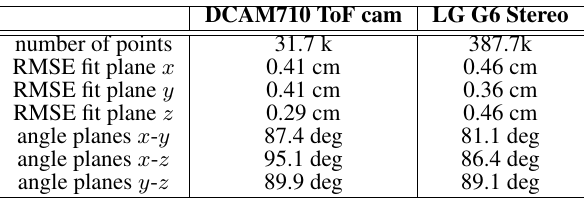
Figure 13. Box reconstructed with stereo vision from images acquired with LG G6 dual camera. Table 4. Comparison between TOF camera and smartphone stereo vision on the reconstruction of a